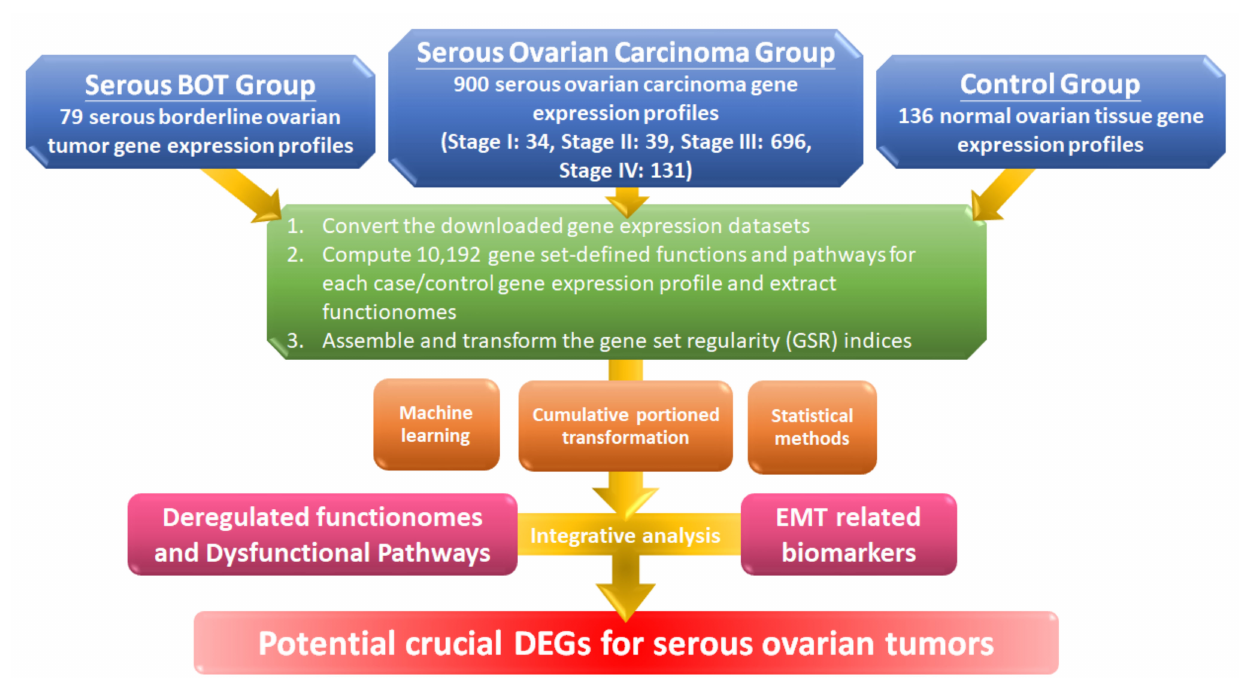
Figure 1. Workflow of this study. The DNA microarray gene expression profiles of 79 serous borderline tumor (BOT) samples, 900 serous ovarian carcinoma specimens including all stages, and 136 normal ovarian controls were downloaded from publicly available databases with gene set regularity (GSR) indices calculated by the Gene Ontology (GO) gene set. Functionomes consisting of 10,192 GO gene sets established from the polygenic models and cumulative portion transformations with machine learning and statistical methods were utilized to identify the functionome-based patterns to investigate dysregulated GO terms, dysfunctional pathways, and biomarkers of epithelial–mesenchymal transition (EMT) together with integrative analysis and to discover potential crucial differentially expressed genes